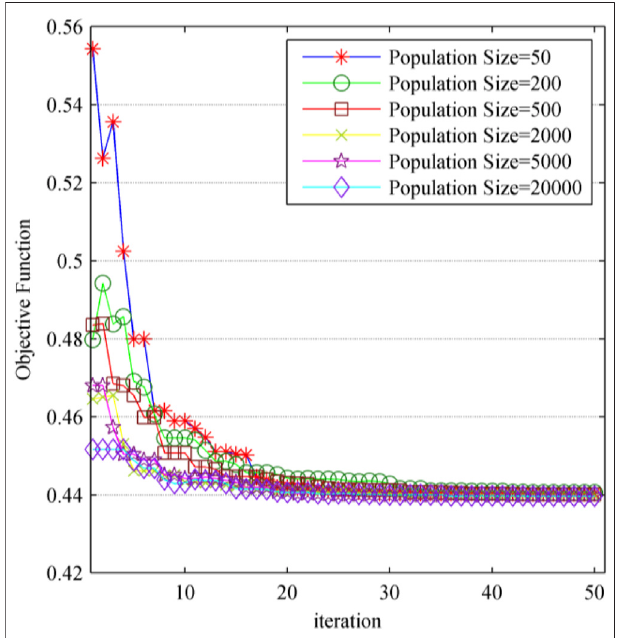
population size in IEEE 118-bus